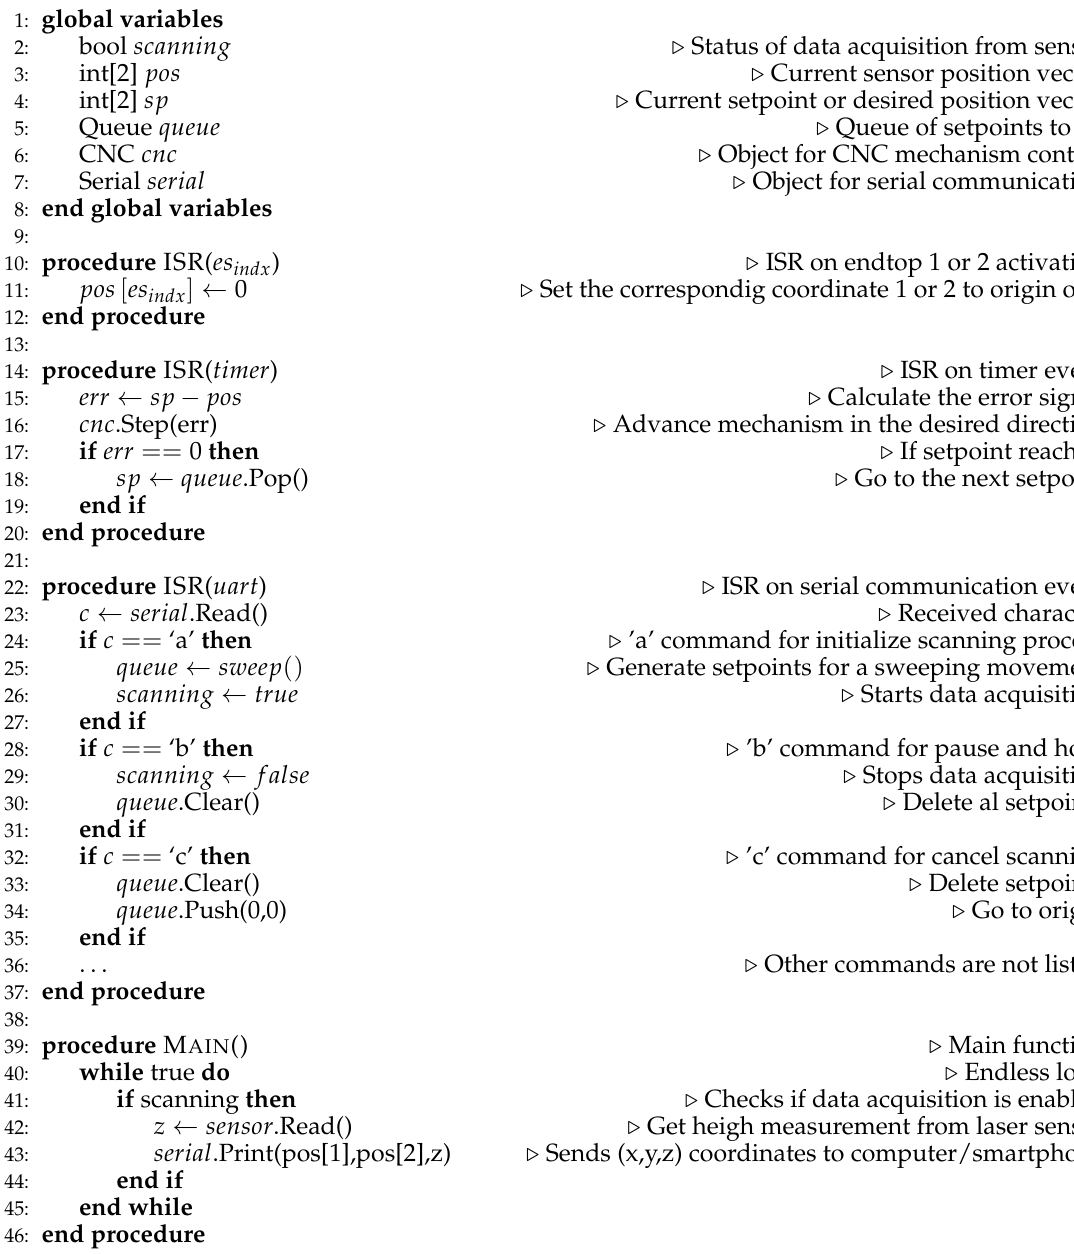
Algorithm 1 Firmware main procedure and